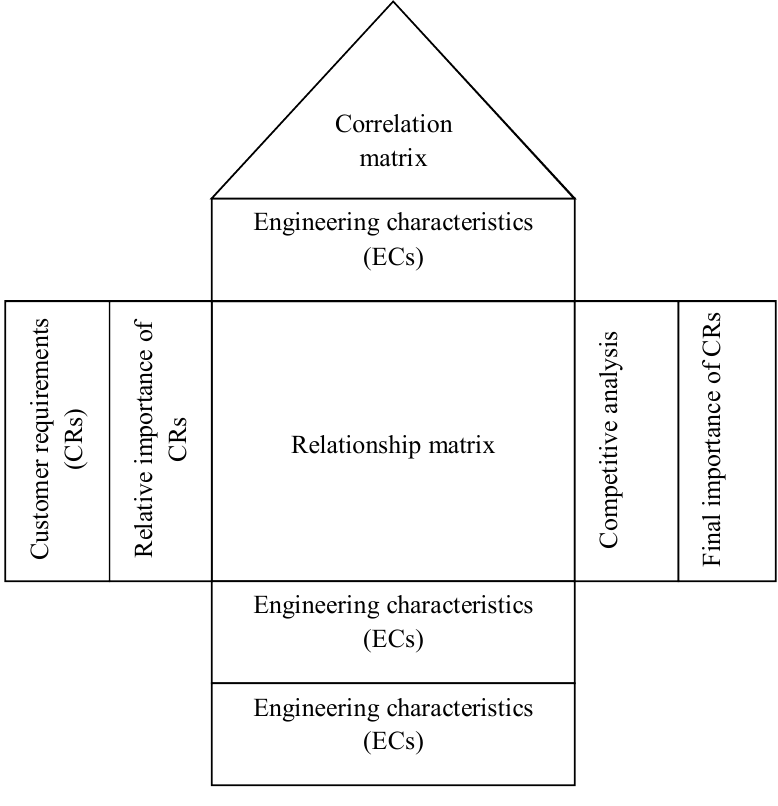
Fig. 1. Components of